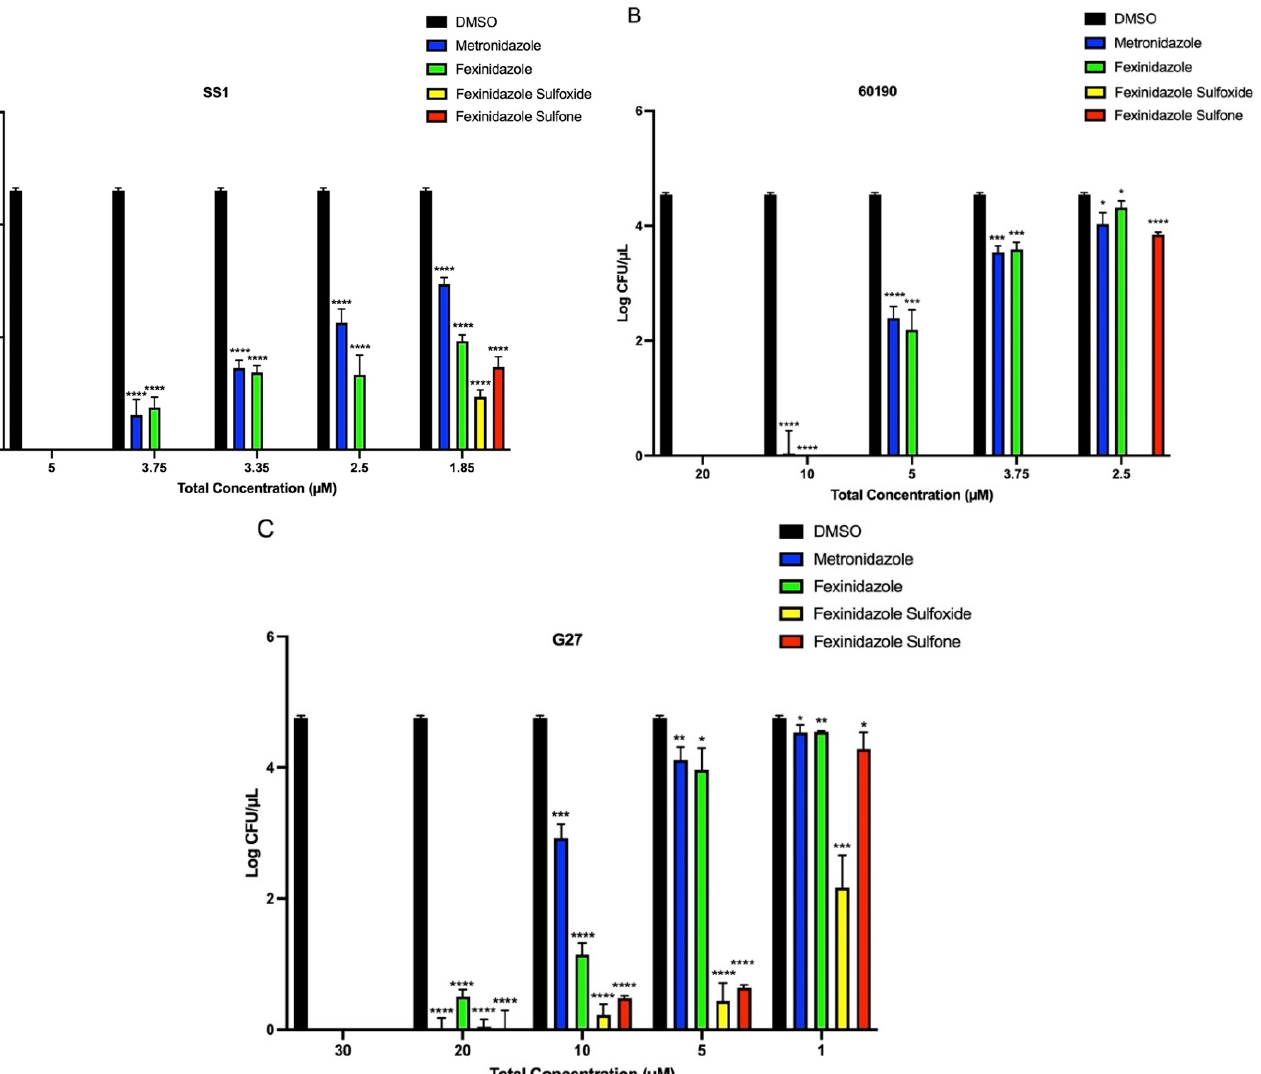
Figure 6. The MIC values of metronidazole, fexinidazole, fexinidazole sulfoxide, and fexinidazole sulfone against different strains of H. pylori . Strains SS1 ( A ), 60190 ( B ), and G27 ( C ) were treated with 1% DMSO or different concentrations of metronidazole, fexinidazole, fexinidazole sulfoxide, and fexinidazole sulfone for 24 h and colonies in agar plates were counted for bacterial growth. Values plotted are means and standard deviations from three different experiments. * p < 0.05, ** p < 0.01, *** p < 0.001, and **** p < 0.0001 by Student’s t-test compared to DMSO-treated H. pylori .